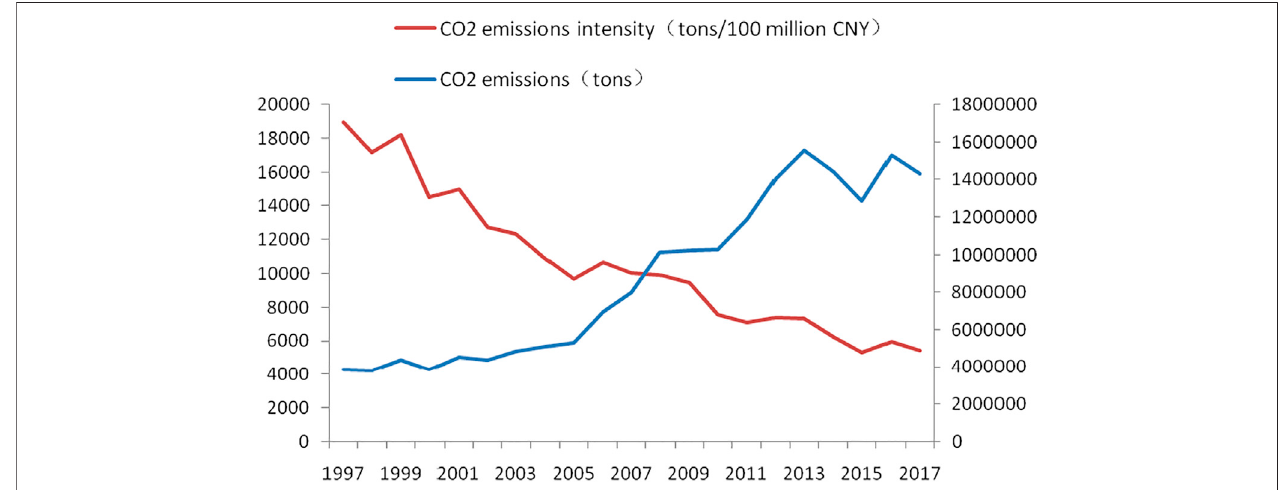
FIGURE 1 | CO 2 emissions and emission intensity in Qinghai Province.